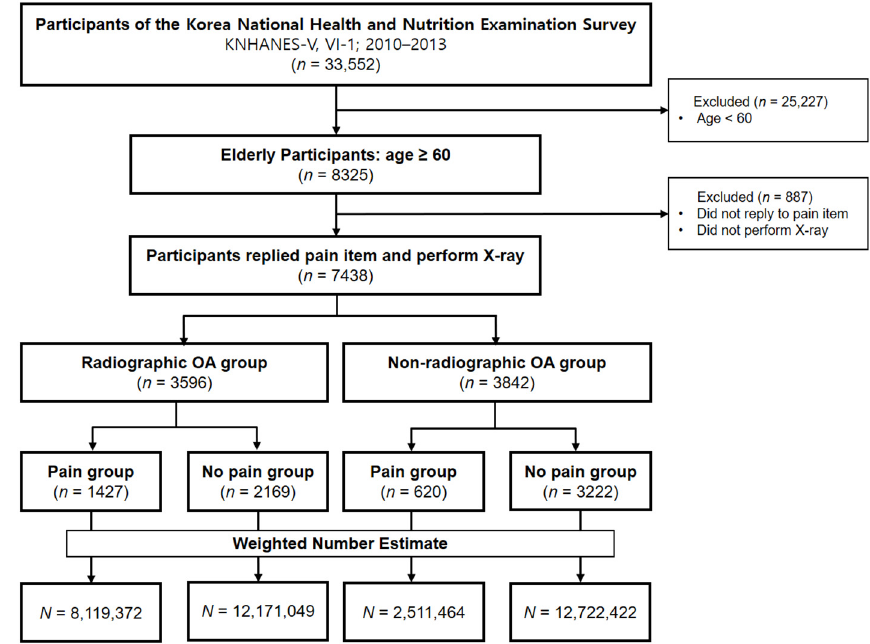
Figure 1. Flow chart of subject selection. OA: osteoarthritis.